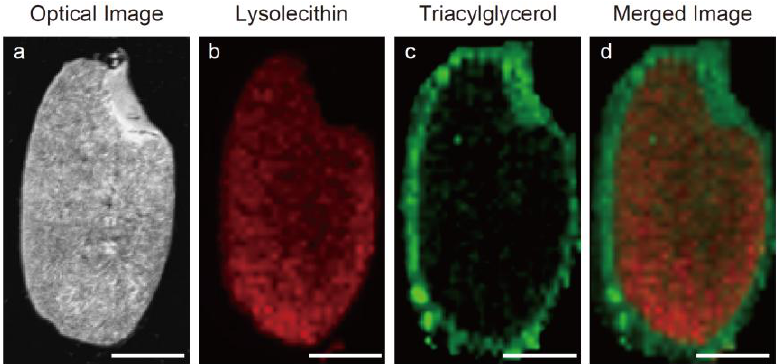
Figure 4. Ion image of nutrients in rice ( Oryza sativa ). Scale bar: 1 mm. ( a ) Optical image of a rice kernel ( Hinohikari ). ( b ) Distribution of lysolecithin. ( c ) Distribution of triacylglycerol. ( d ) Merged image of lysolecithin (red) and triacylglycerol (green). The rice kernel section can be prepared using adhesive